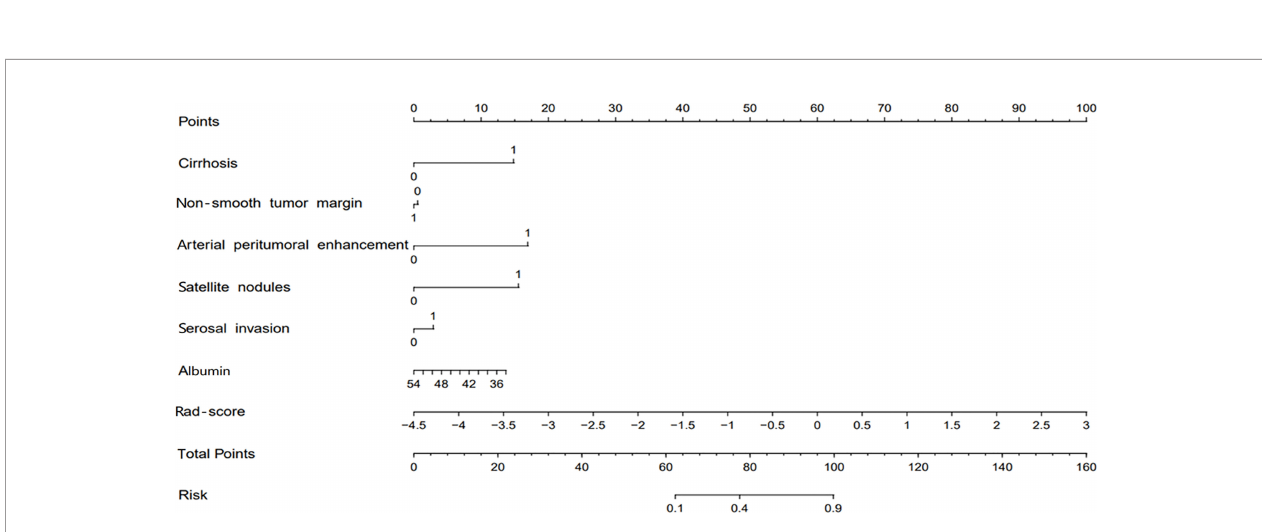
FIGURE 4 | The radiomics nomogram for predicting early recurrence.